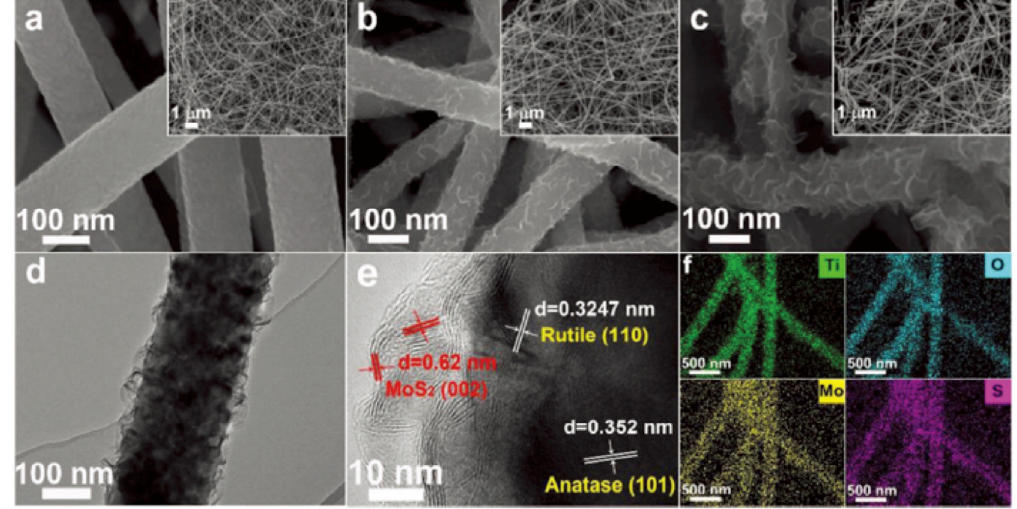
Figure 10. SEM images of ( a ) pristine TiO 2 fibers, ( b ) 10% MoS 2 / TiO 2 , ( c ) 25% MoS 2 / TiO 2 ; (insets: corresponding low-magnification SEM images), ( d ) TEM, ( e ) HRTEM images and ( f ) EDX element mappings for 10% MoS 2 / TiO 2 , reprinted with permission from [105].